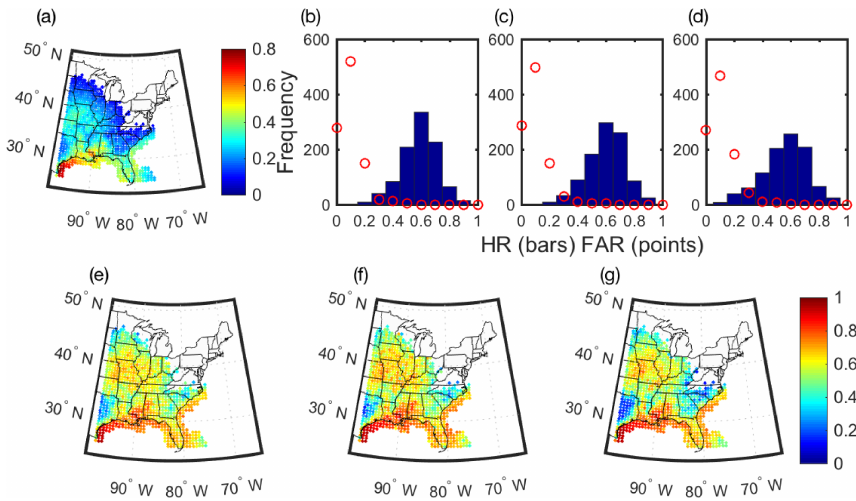
Figure 6. (a) Map of the fractional frequency of occurrence of maximum θ e > 347K in each grid cell based on the independent (test) data set. (b) Histogram of hit rate (HR) and false alarm rate (FAR) for all grid cells and (e) spatial map for correct identification of maximum θ e > 347K for all grid cells where this threshold is exceeded by > 8% of days in the independent data based on output from the multiple linear regression model (MLR). (c, f) As in panels (b) and (e) but for output from the ANN model with three hidden layers and including SM (ANN-HL3-SM). (d, g) As in panels (b) and (e) but for output from the ANN model with 3 hidden layers excluding SM